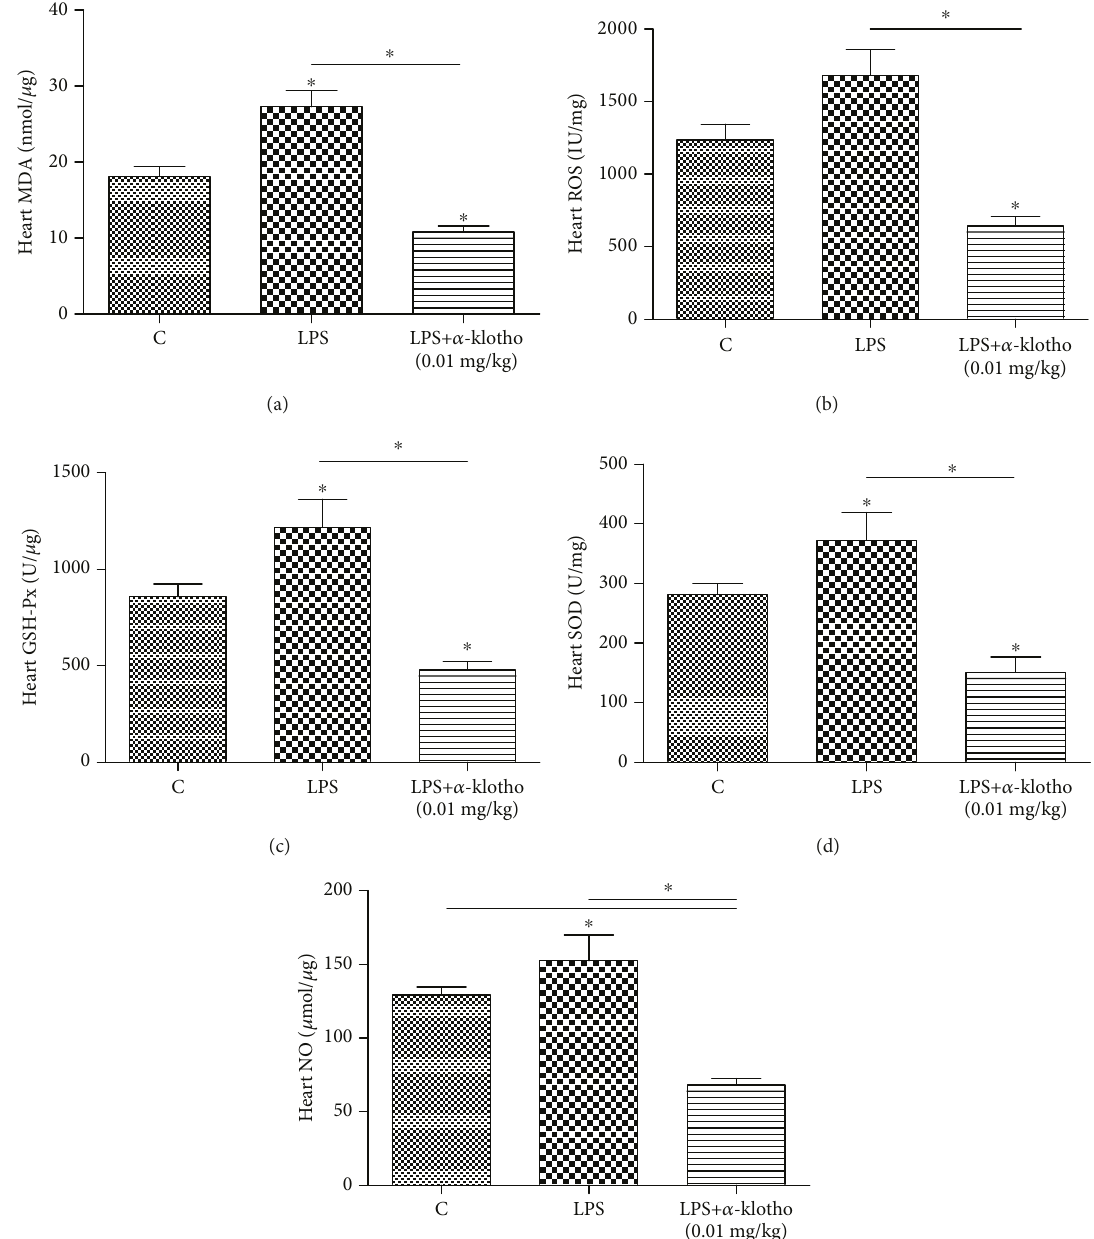
Figure 6: α -Klotho reduced LPS-induced oxidative stress in mouse heart (a – e). Heart tissues were collected at 24 h after LPS injection in the control group ( n = 6 ), LPS group ( n = 6 ), and LPS+ α -klotho (0.01 mg/kg) group ( n = 6 ). The mRNA levels of MDA (a), ROS (b), GSH-Px (c), SOD (D), and NO (e) were measured by ELISA. ∗ p < 0 05